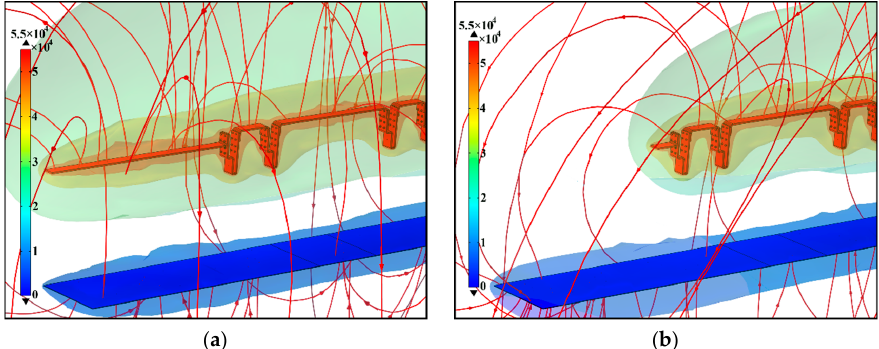
Figure 6. Effect of long busbar on electric field. ( a ) Before removal of busbar; ( b ) After removal of busbar.